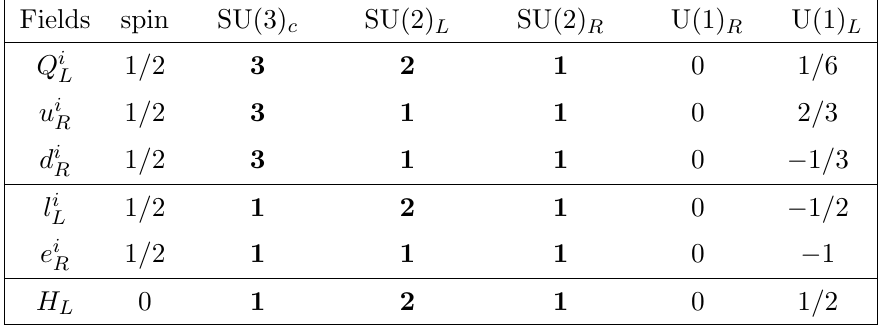
Table 1 . Matter content in the SM sector. i denotes the (cid:13)avors: i = 1 ; 2 ; 3. Fields